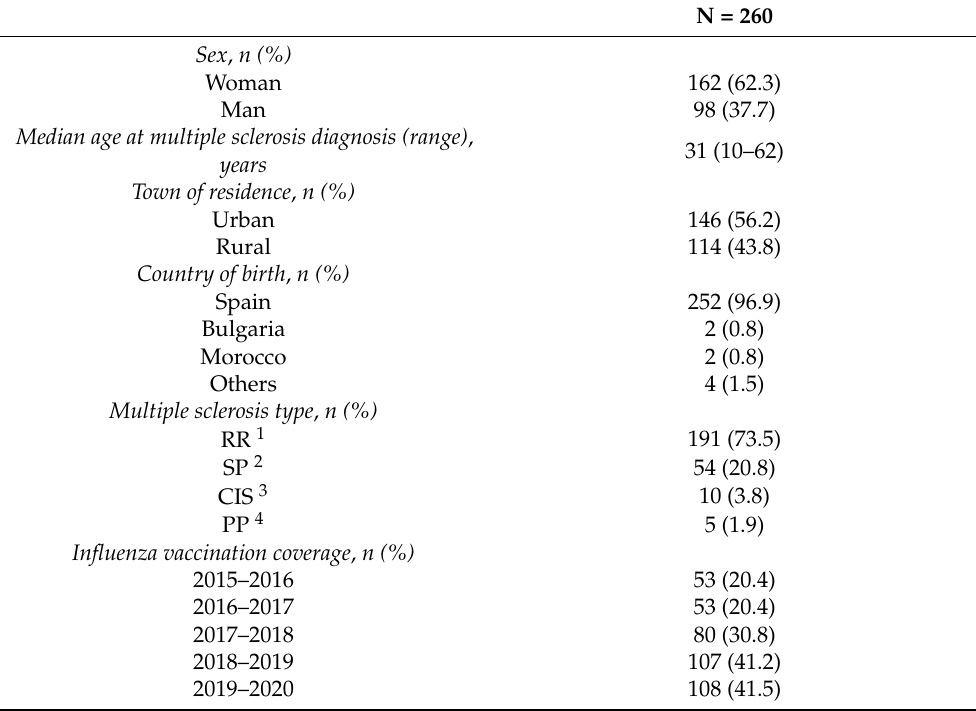
Table 3. Results of the descriptive analysis.